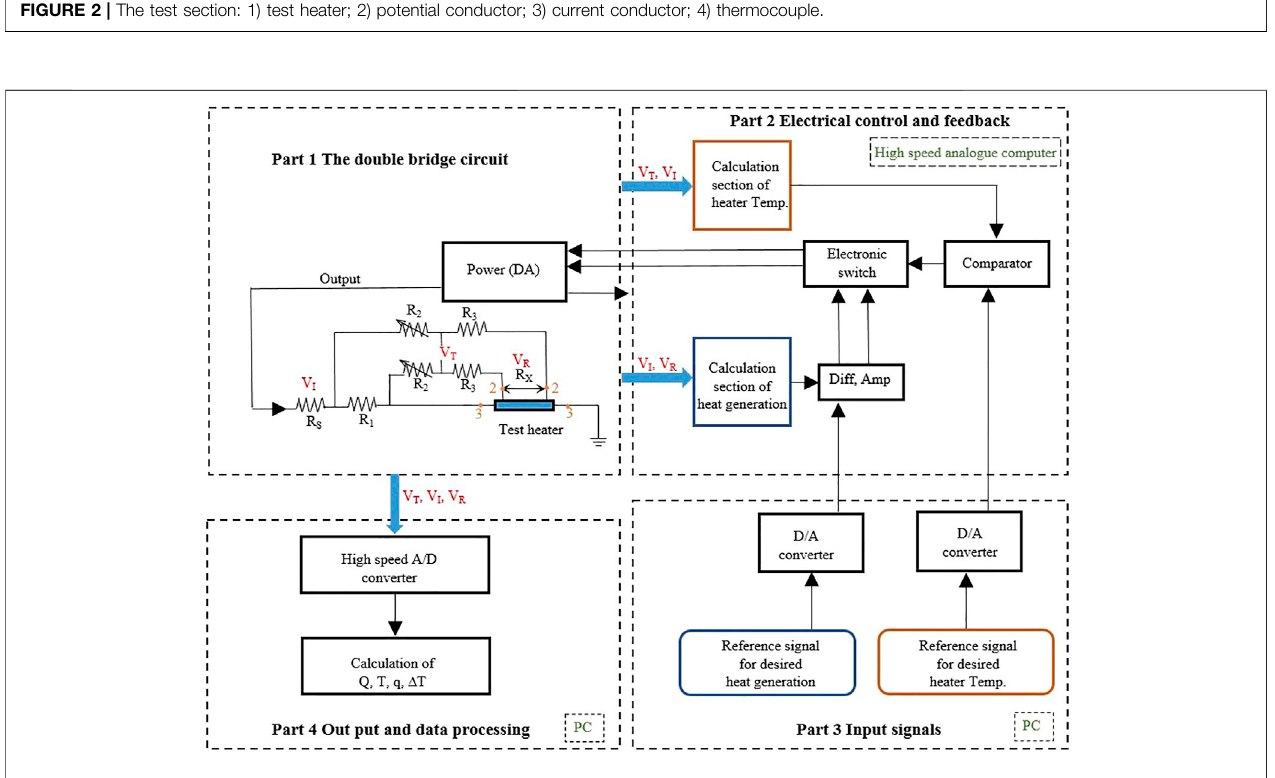
FIGURE 3 | Electrical control and measurement